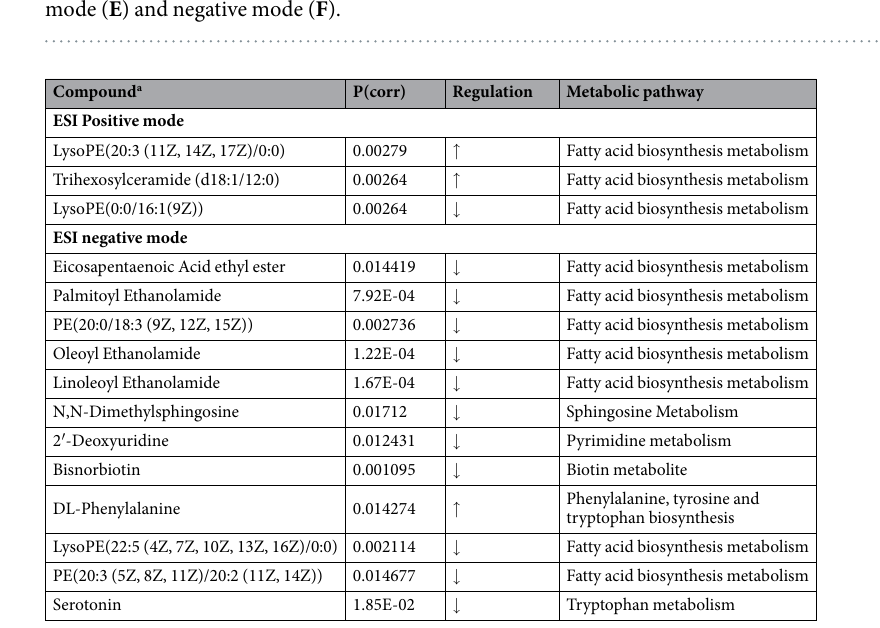
Figure 3. Metabolic profiling of serum samples in HFD and ND mice. The typical base peak ions chromatograms (BPCs) of serum samples from HFD ( A , B ) and ND ( C , D ) in ESI positive ( A , C ) and negative mode ( B , D ). Score plots of PCA analysis for serum samples from [HFD ( ▪ ), ND ( ▪ )] groups in ESI positive mode ( E ) and negative mode ( F ).